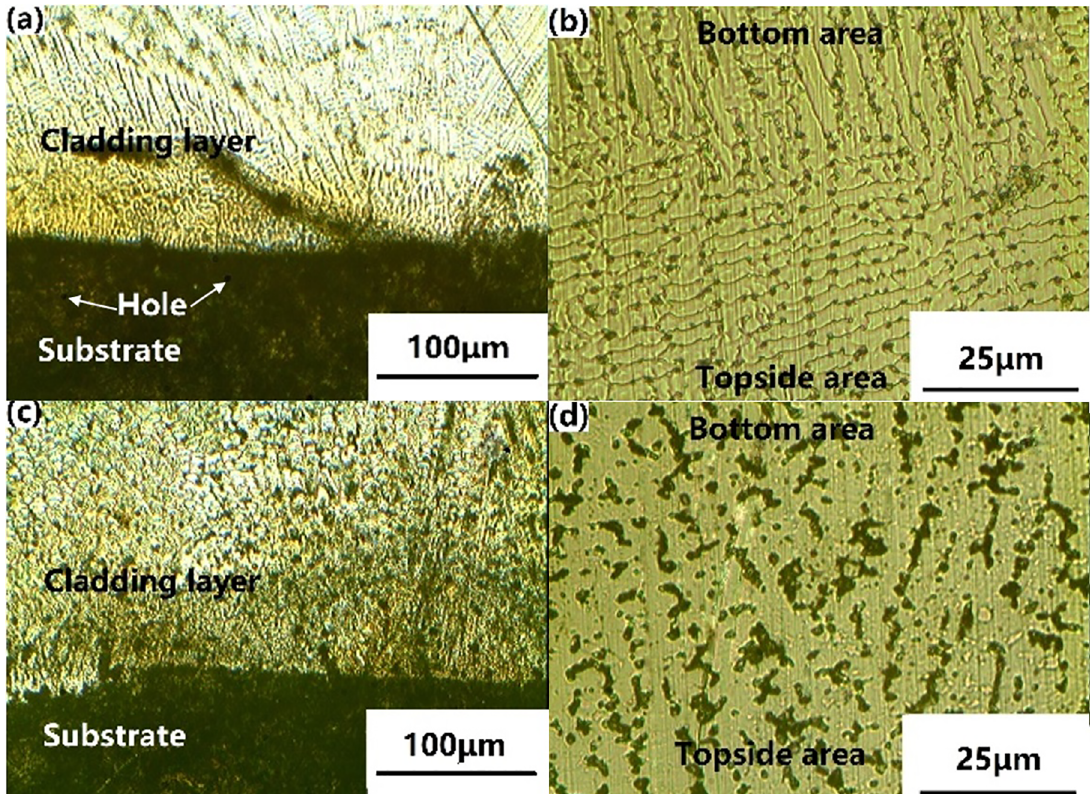
Figure 3. OM images of AlCoCuFeMnNi alloy without (a, b) and with (c, d) 1wt% CeO